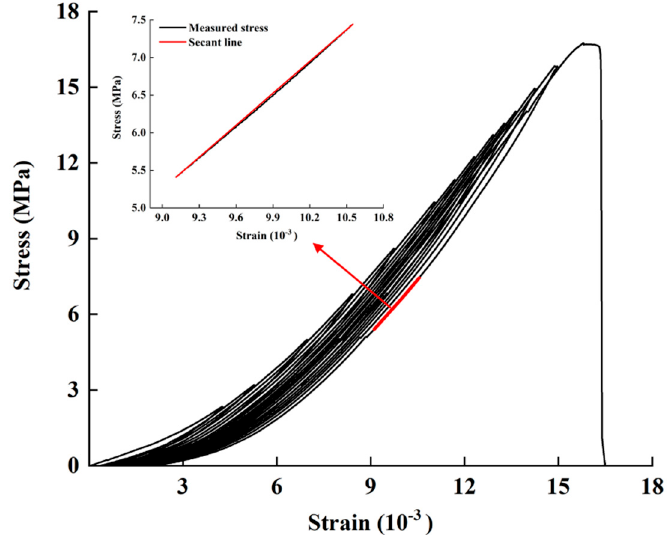
Figure 3. Stress ‐ strain curve measured for the specimen No. 11 during cyclic loading. Figure 3. Stress-strain curve measured for the specimen No. 11 during cyclic